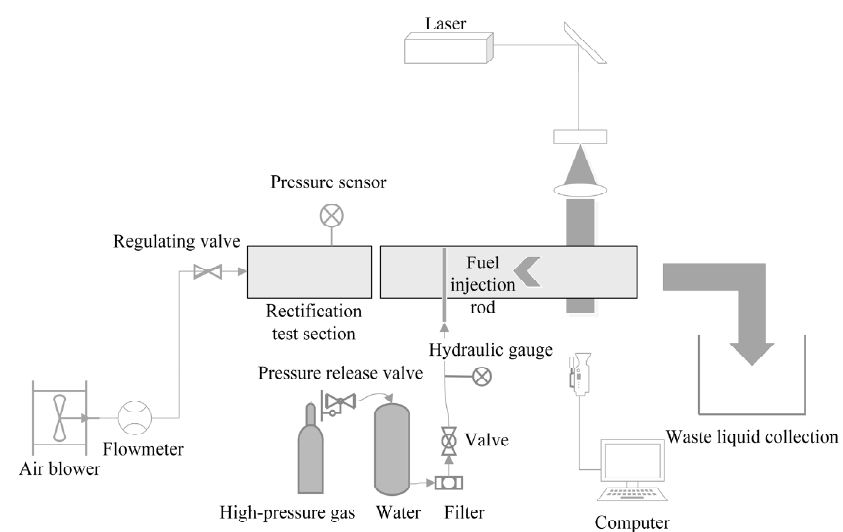
Figure 5. Schematic diagram of the experimental system.